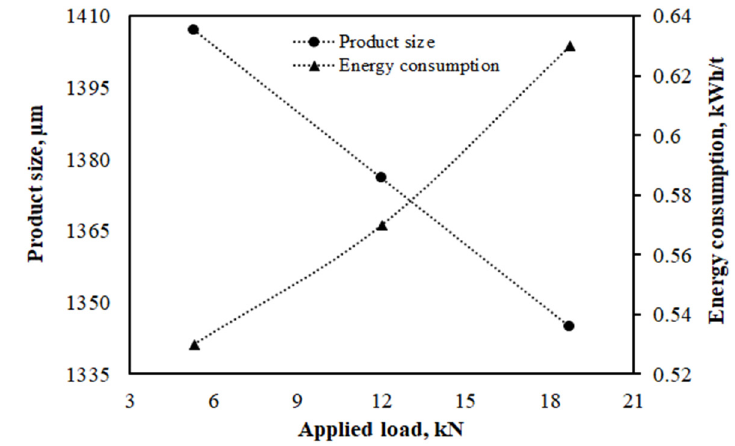
Figure 5. Effect of applied load on product size and energy consumption at 1.2 mm gap and 650 rpm roller speed.